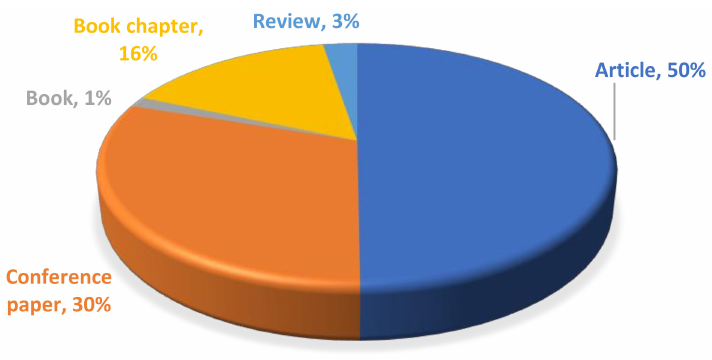
Figure 3. The types of documents published in the years 2005–2020. Half of these documents were publications classified as articles (675), second place occurring types of publication were reviews (35) and books (19).